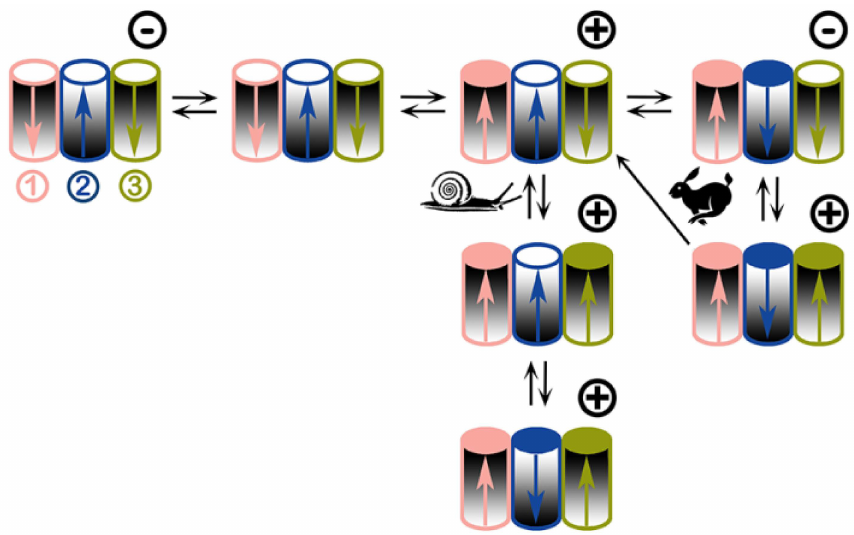
Figure 7. Proposed voltage-gating model of triplin channels. Each triplin consists of three cylindrical channels arranged in a row. The orientation of each channel is indicated by the graded shading. Thus, the middle cylinder (channel 2) has an orientation opposite to that of its neighbors. Each channel has its own gating charge whose asymmetric distribution results in a dipole (arrow). The tip of the arrow is the negative end. An open channel is designated by a white circle on top, a closed one has a colored circle. Channel closure translocates the charged voltage sensor through the membrane thus inverting the dipole moment (i.e. inverting the arrow). The orientation of the channel is not changed. Adjacent channels influence each other through dipole-dipole interactions. The applied voltage is indicated by the symbol at the upper right corner of each triplin. All three channels are open when no potential is applied (upper left). From an all channels open state, a high positive voltage induces closure of channel 1 whereas a negative voltage has no e ff ect. Snail path: with a constant voltage, adjacent dipoles stabilize the structure thus inhibiting channel closure resulting in slow rates of closure. With time a high positive voltage closes both channel 1 and 3. Cooperation with its neighbors forces channel 2 to close despite the wrong sign of the applied voltage. Rabbit path: using triangular voltage ramps, the closure of channel 1 favors closure of channel 2 due to favorable dipole-dipole interaction. Channel 2 closure occurs at negative voltages due to its opposite orientation. Dipole-dipole interaction between 2 and 3 requires 2 to be closed for 3 to close. When fast triangular voltage ramps are applied, the slow rate of opening of channel 2 results in 2 remaining closed at positive potentials long enough for channel 3 to close. This leads to the all-closed structure at the lower right. As the voltage is reduced there are only two outcomes: either channel 3 reopens followed by channel 2 or channel 3 and 2 can reopen simultaneously (one-way